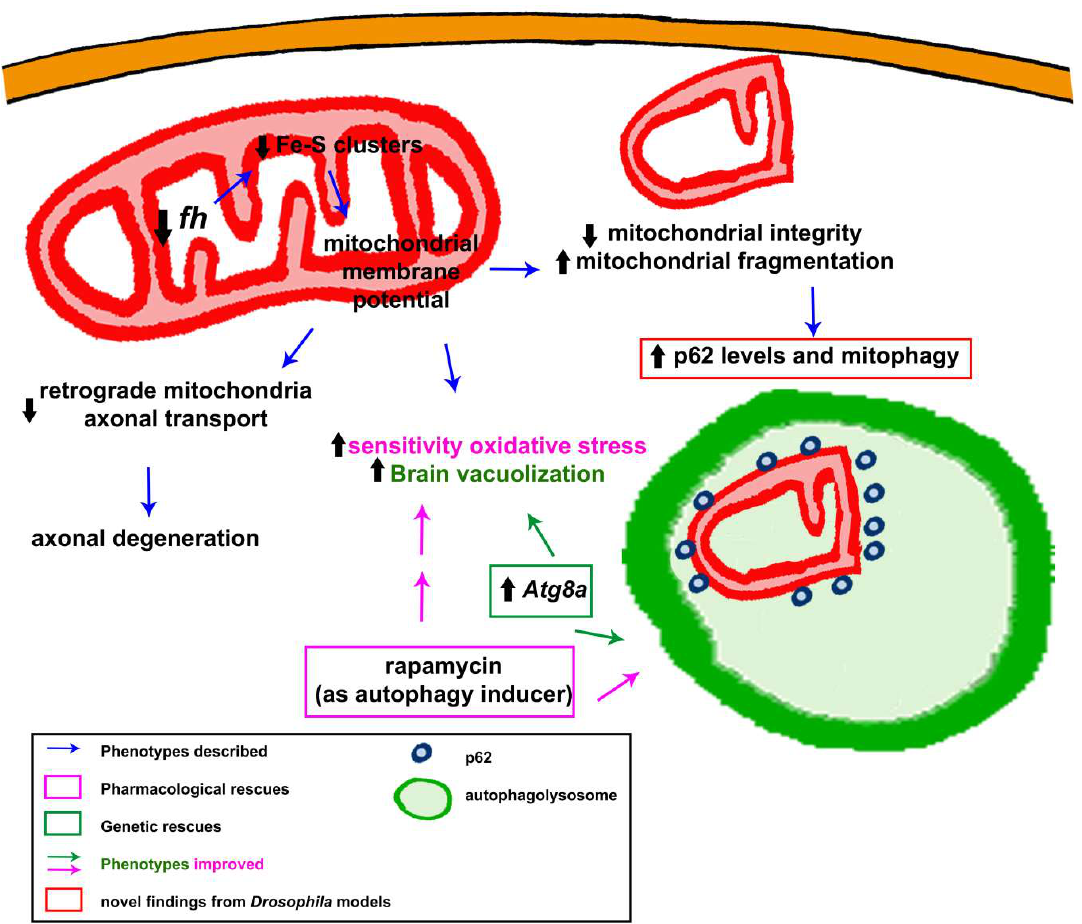
Figure 4. Graphic summary of molecular defects and rescues described in Drosophila melanogaster models of frataxin-deficiency in relation to the cellular mitochondrial network.